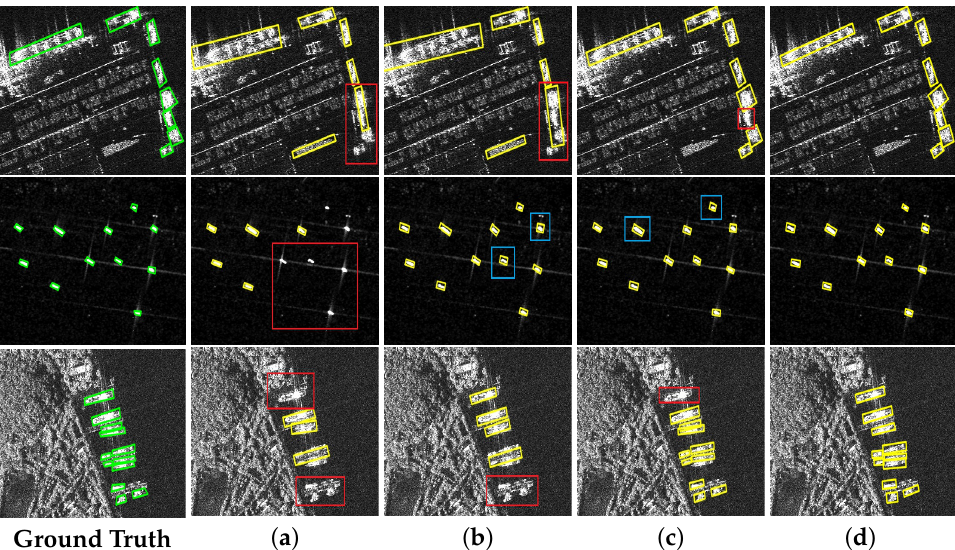
Figure 16. Comparison of experiment detection results on the SSDD+ dataset. The green box in the first column represents the ground truth. The yellow box indicates the detection result. The red box indicates the missed detection area, and the blue box indicates the inaccurate detection area. ( a ) The detection result of Faster R-CNN. ( b ) The detection result of RoI transformer. ( c ) The detection result of Gliding vertex. ( d ) The detection result of